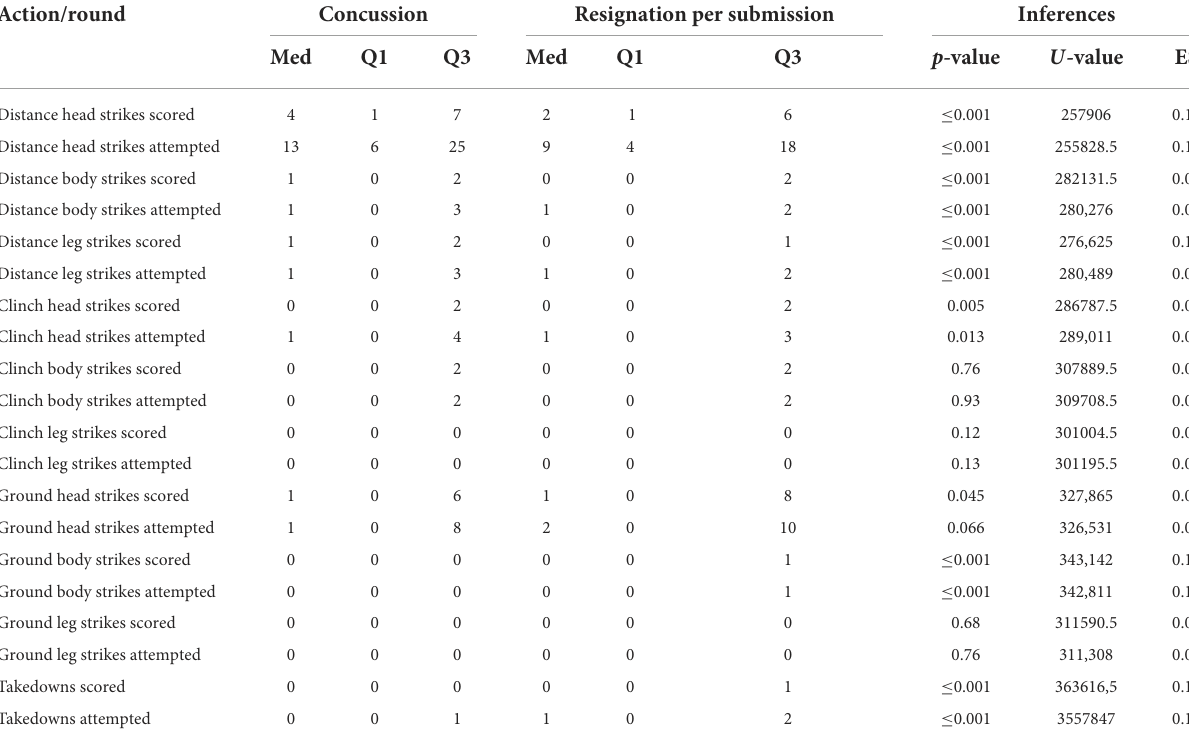
TABLE 2 Striking and grappling actions compared by concussion and resignation per submission groups by round.